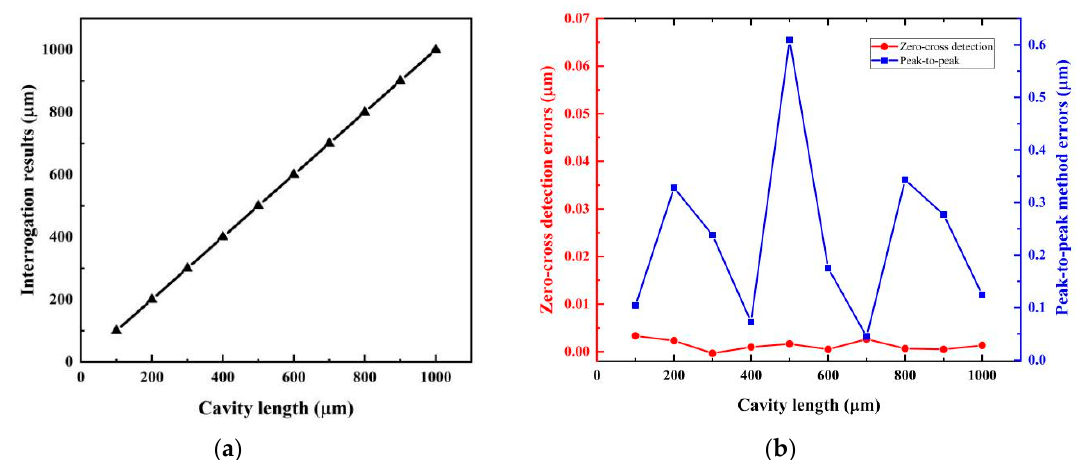
Figure 8. ( a ) Simulated cavity length interrogation results for 10 different FP cavity lengths in the range 100–1000 μ m under a signal-to-noise ratio (SNR) of 20 dB; ( b ) cavity length calculating errors acquired